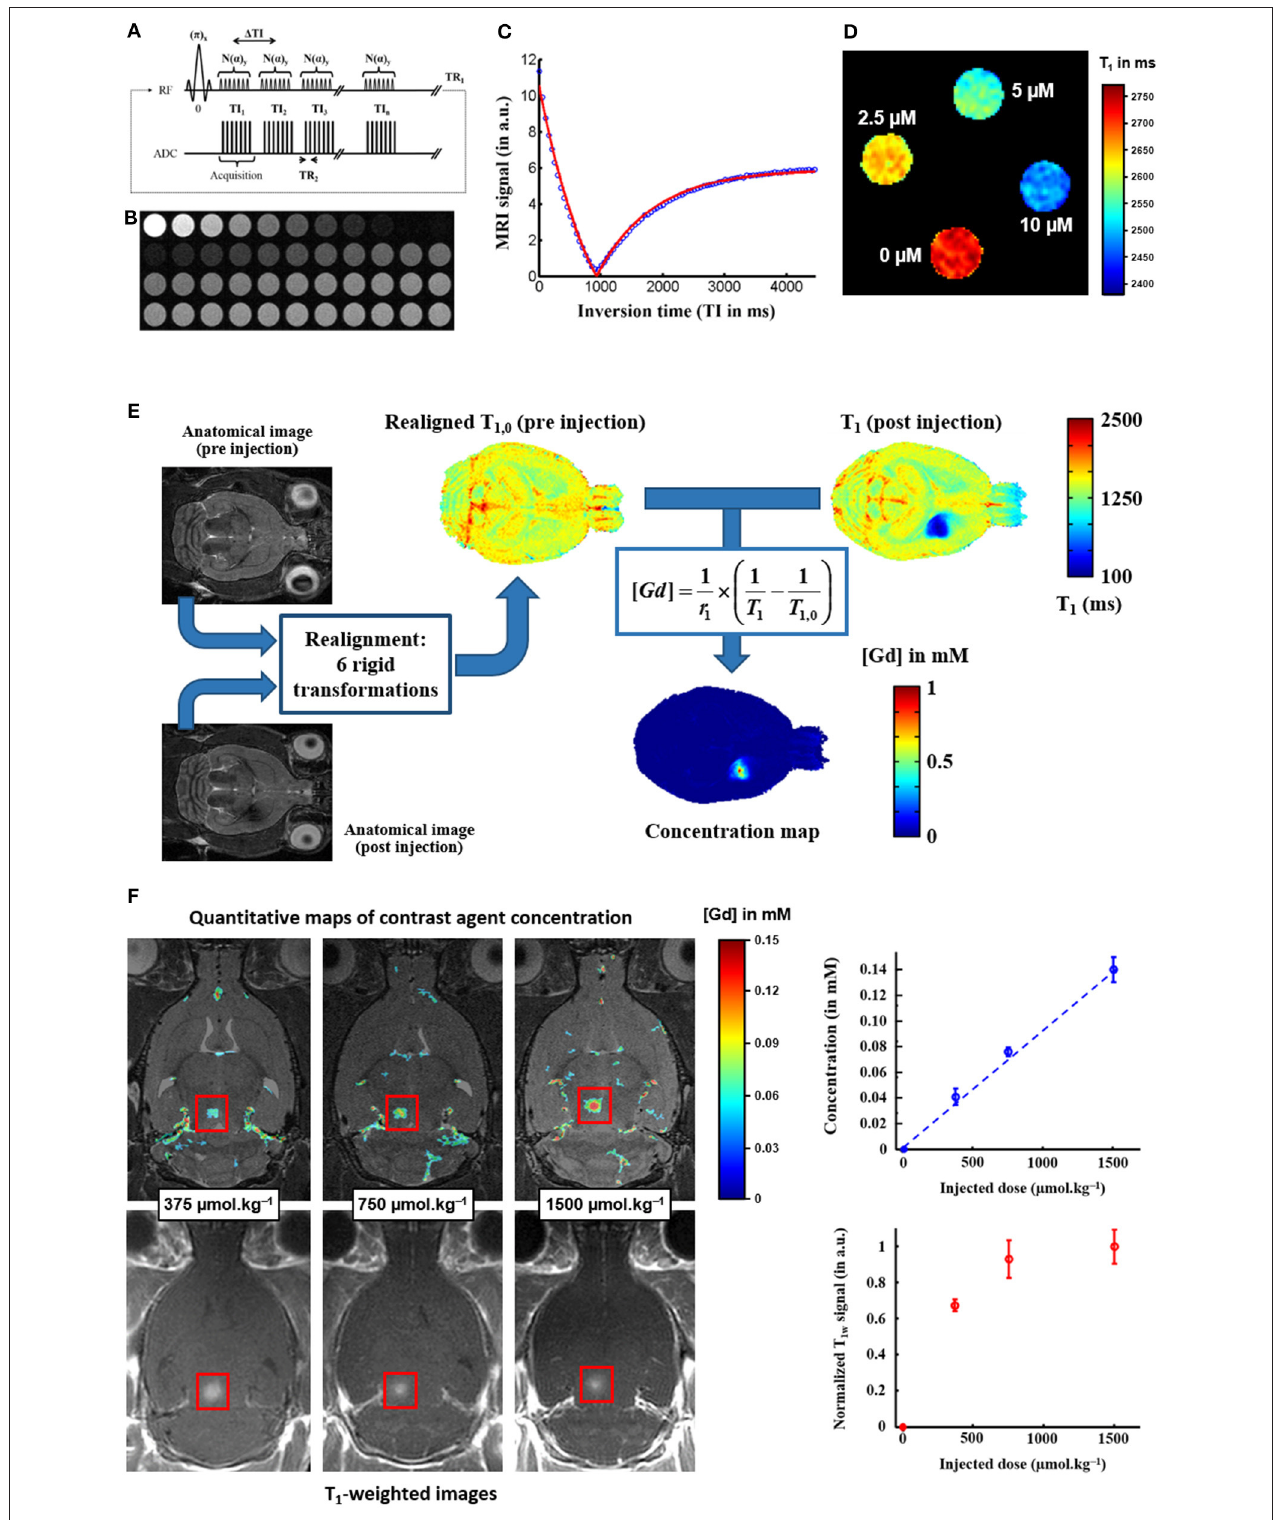
FIGURE 1 | MRI quantification of Gadolinium-based contrast agent concentration. (A) The T 1 mapping strategy is based on one Inversion Recovery Fast Gradient Echo sequence: it consists of a segmented series of fast gradient echo images (B) acquired at different time points after magnetization inversion. (C) The recovery